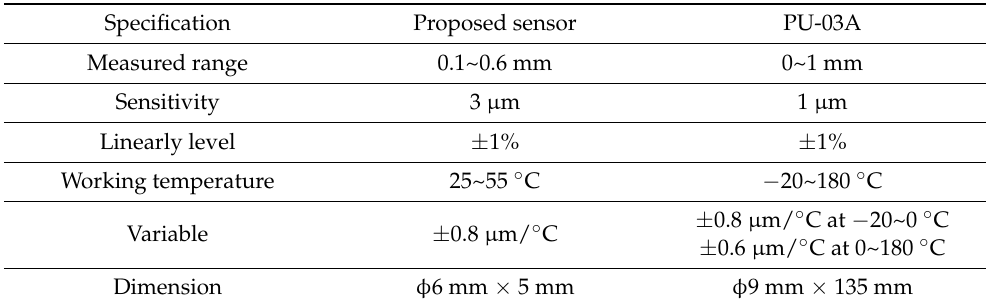
Table 1. Specifications of commercial AEC PU-03A EC displacement sensor and proposed sensor.